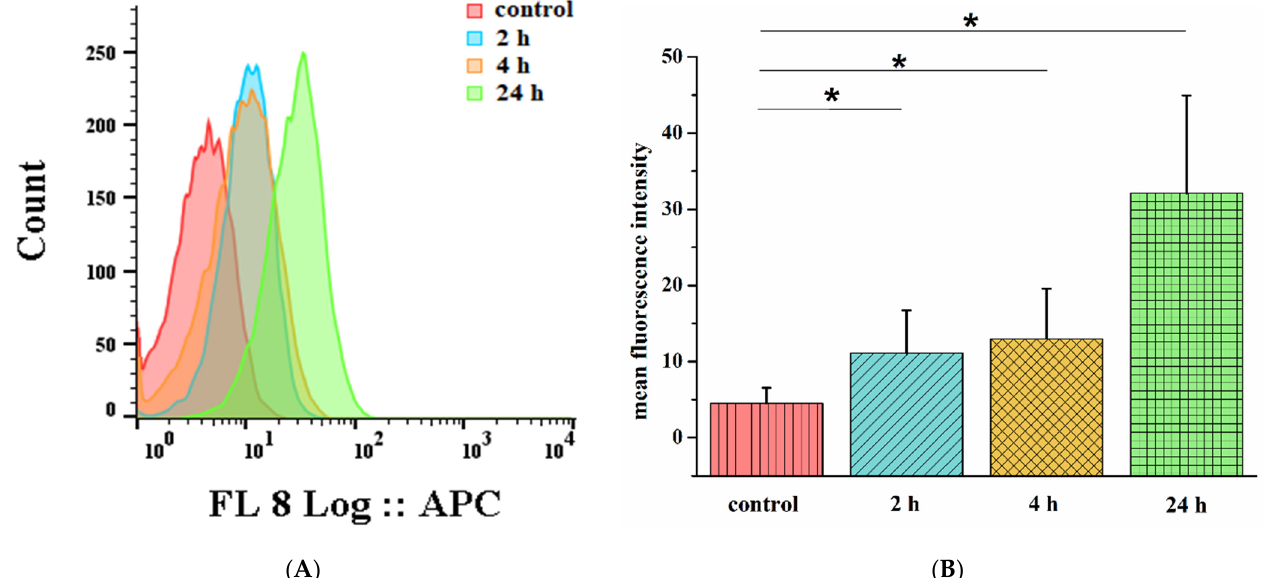
Figure 5. Flow cytometry analysis of MCF-7 cells treated with 3 µM of conjugate 7 for 2 h (blue), 4 h (orange), and 24 h (green), where nontreated control cells are marked in red ( A ). MFI of MCF-7 cells treated with 3 µM of conjugate 7 for 2 h, 4 h, and 24 h ( B ). Data represent mean ± SD and * p < 0.05 compared with control.